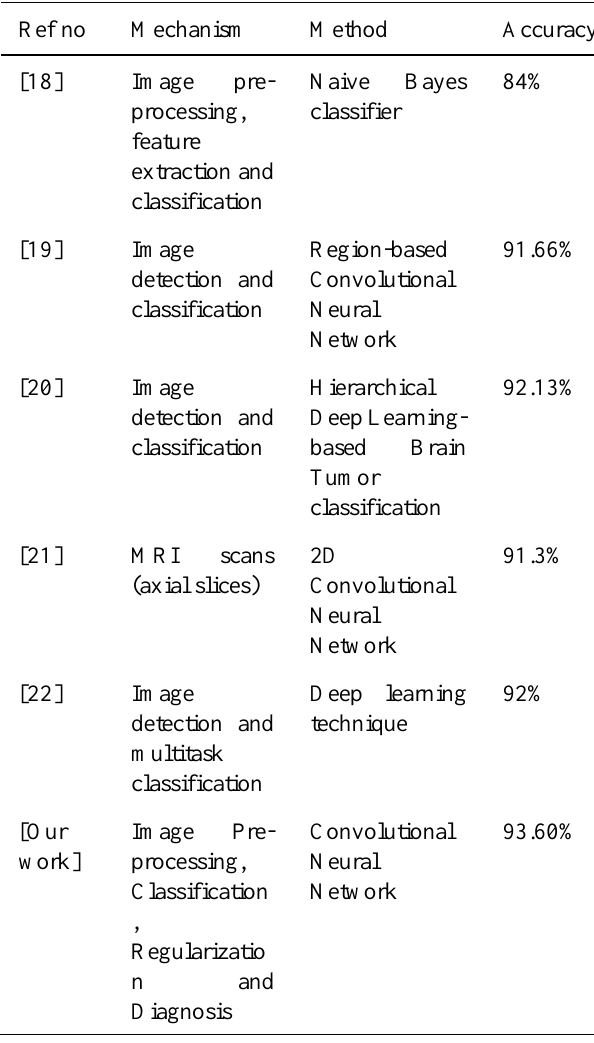
Comparative analysis of presented work and previous